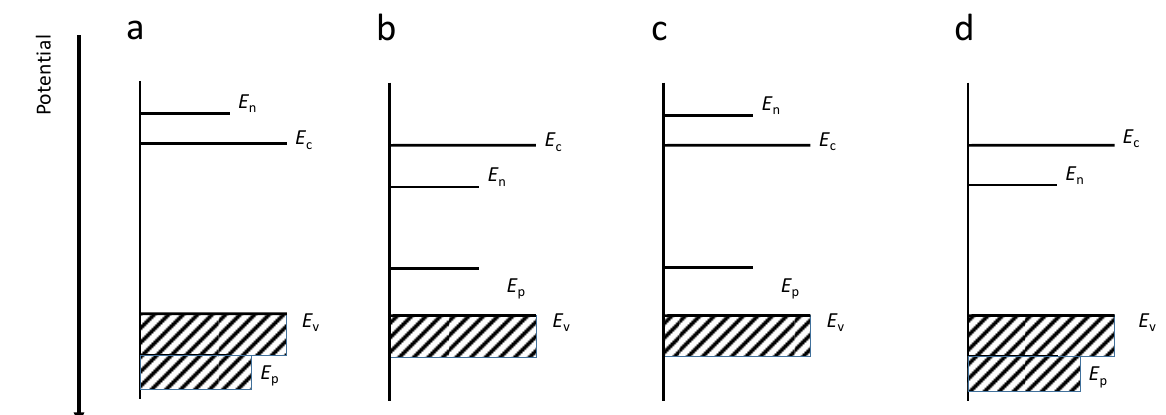
Figure 8. Models of thermodynamic stability. ( a ) Thermodynamic stability, ( b ) possible anodic and cathodic photodegradations, ( c ) possible anodic degradation, ( d ) possible cathodic degradation. E v —valence band, E p —redox potentials of anodic decomposition reactions, E n —redox potentials of anodic and cathodic decomposition reactions, E c —conduction band.